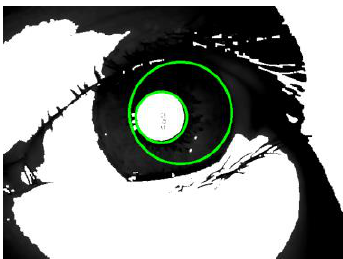
Figure 11. Example of the circle range of the detected different center and radius in the iris Figure11. Exampleofthecirclerangeofthedetecteddi ff erentcenterandradiusintheirisconnectedarea. connected area. It can be seen from Figure 11 that the gray value of a point inside a circle that can well reflect the pupil range is mostly 255. The design of the conceptual label of the pupil should satisfy this phenomenon.